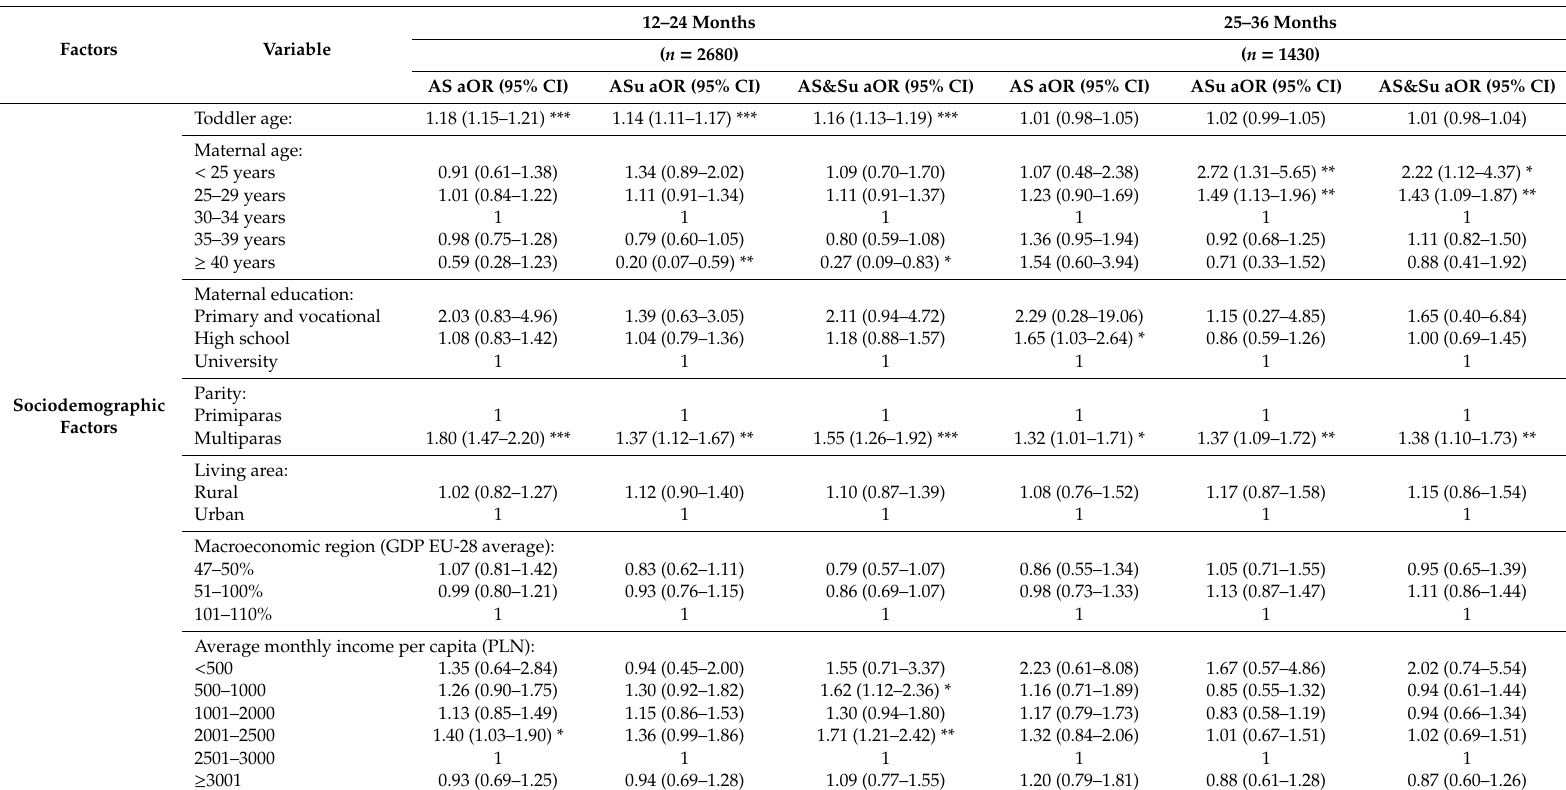
Table 2. Multivariate regression analysis models of factors influencing the use of added salt, sugar, and salt and sugar in the Polish toddlers ( n = 4110).